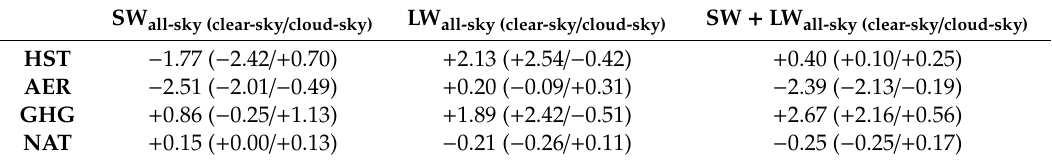
Table 6. The land-mean linear trend (Wm − 2 decade − 1 ) of the JJA-mean downwelling SW, LW, and the net radiation at the surface from the HST, AER, GHG, and NAT simulations for P3. The numbers in the parenthesis are the corresponding values for the clear-sky and cloudy-sky